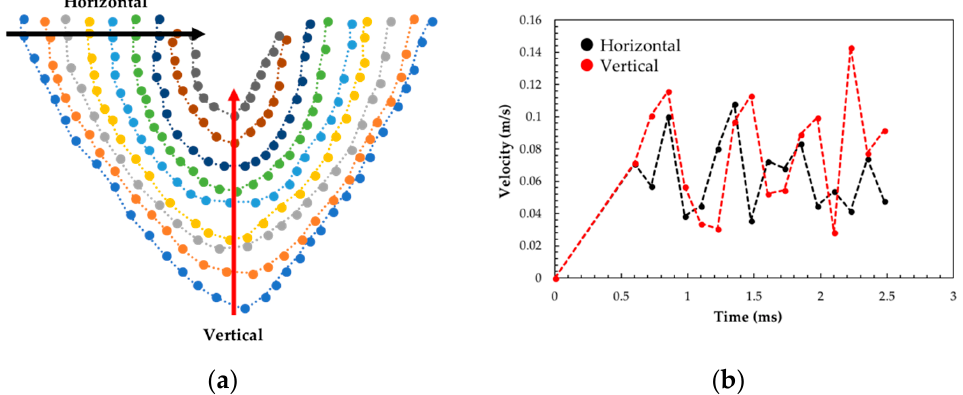
Figure 5. ( a ) Progression of the solid–liquid interface of a spot-melt for a series of 0.25 ms time-steps with labeled directions of velocity extraction; ( b ) solidification velocities as a function of time in the horizontal and vertical directions of the spot-melt presented in ( a ).